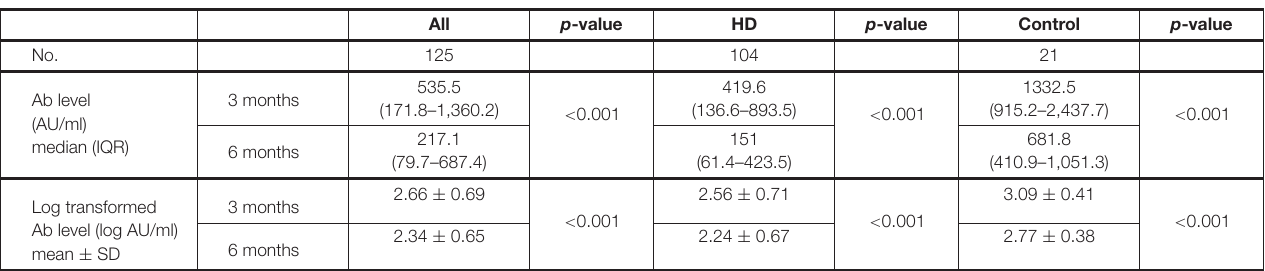
TABLE 3 | Anti-S1-RBD IgG levels and log transformed anti-S1-RBD levels at 3 and 6 months for the study and control